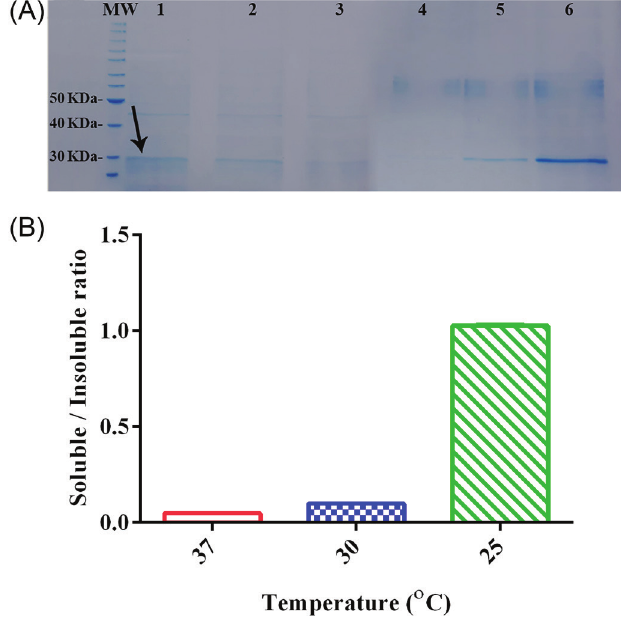
FIGURE 5 - The effect of induction temperature on solubility of anti-HER2 scFv expressed in Origami (DE3). A) The soluble fractions of cell lysates after induction with 1 mM IPTG at 25 (lane 1), 30 (lane 2) and 37 ° C (lane 3) for 24 h. The insoluble fractions of cell lysates after induction with 1 mM IPTG at 25 (lane 4), 30 (lane 5) and 37 ° C (lane 6) for 24 h. B) The soluble/ insoluble ratio of anti-HER2 scFv expression in E. coli Origami (DE3) at different temperatures which were evaluated by using the Total Lab TL 120